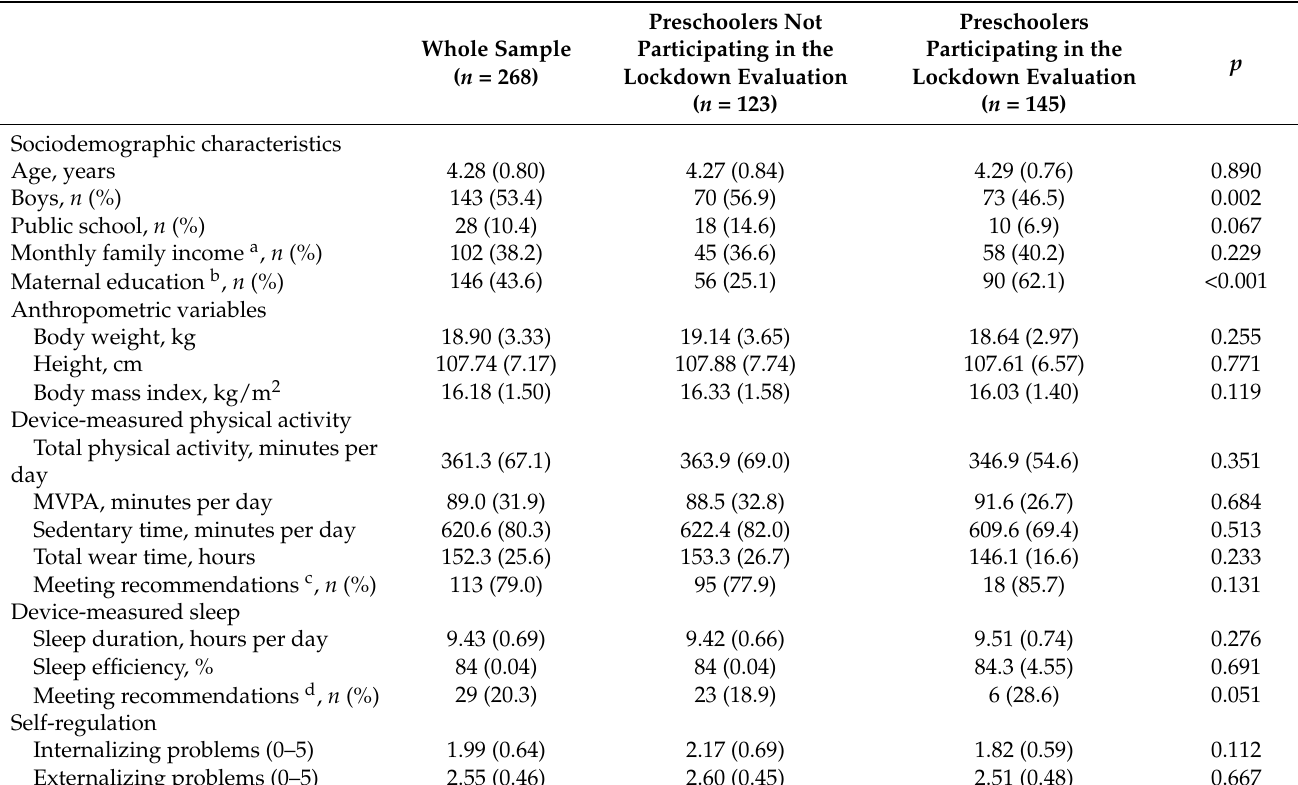
Table 1. Characteristics of the whole sample of preschoolers participating in the study before the lockdown, and differences in baseline characteristics between preschoolers that participated or not in the lockdown